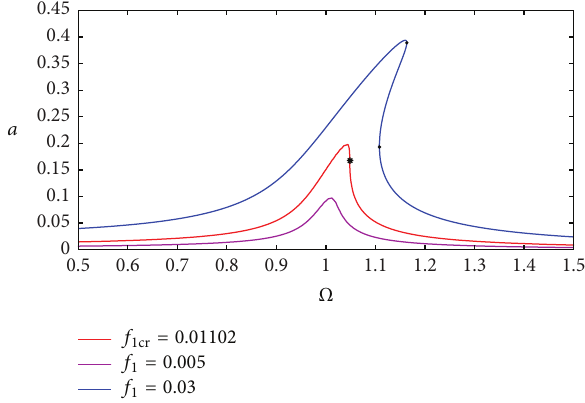
Figure 7: Amplitude-frequency relationship of the primary res- onance for the controlled system under different excitation force amplitude without time delay ( 𝜁 1 = 0.025 , 𝜁 3 = 0.05 , 𝑘 = 1 , and ̂𝜆 = 0.4